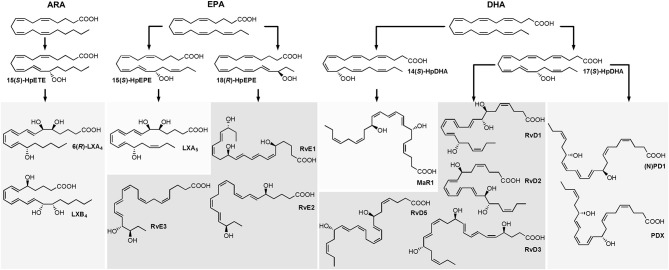
Structure and suggested formation routes of SPMs including ARA derived 4-series lipoxins, EPA derived 5-series lipoxin and E-series resolvins as well as DHA derived maresins, D-series resolvins and protectins.